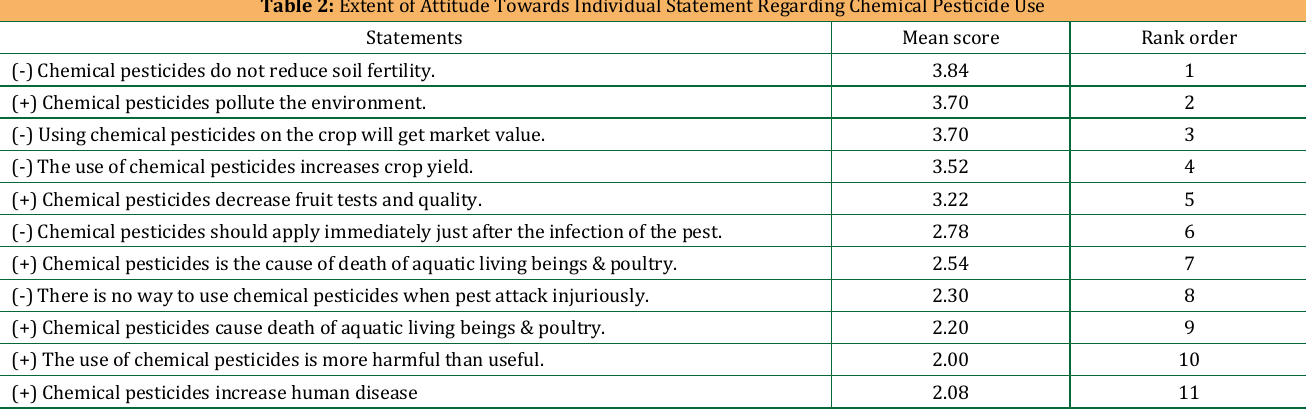
Table 3: Relationship Between Selected Characteristics of the Farmers and Their Attitude Toward Chemical Pesticide Application Focus